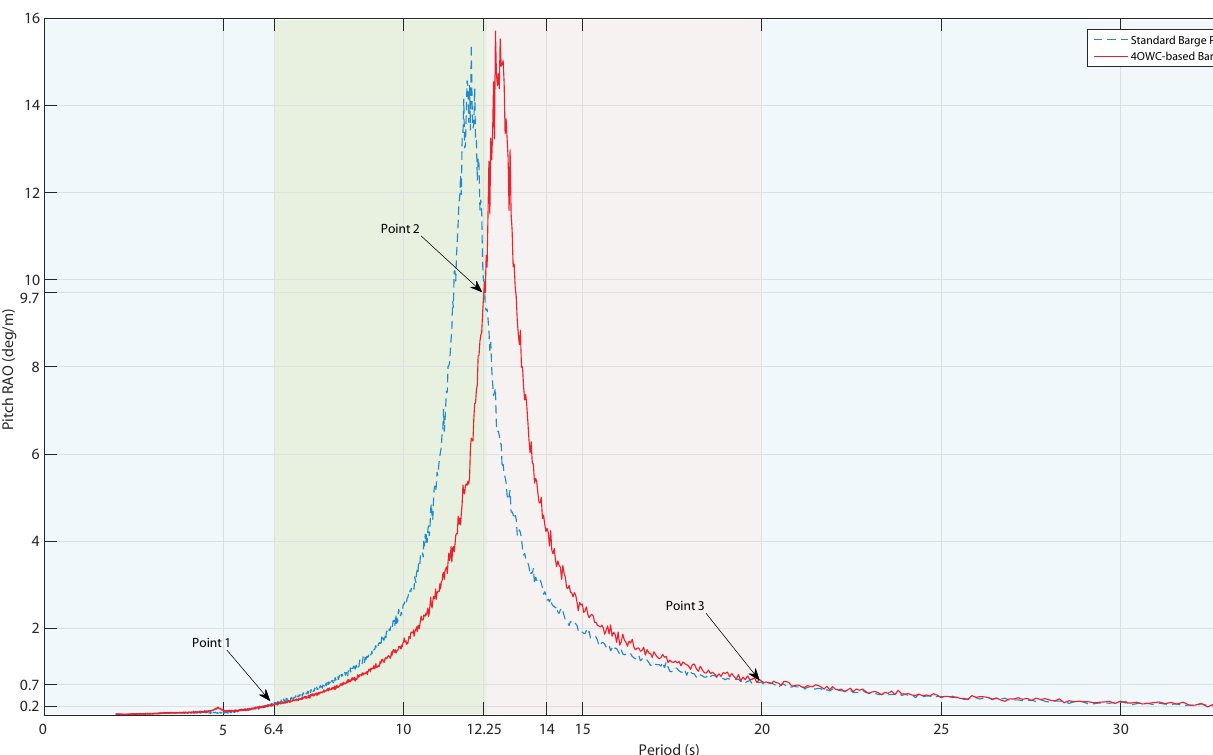
Figure 6. Standard barge platform and 4OWC-based barge platform pitch